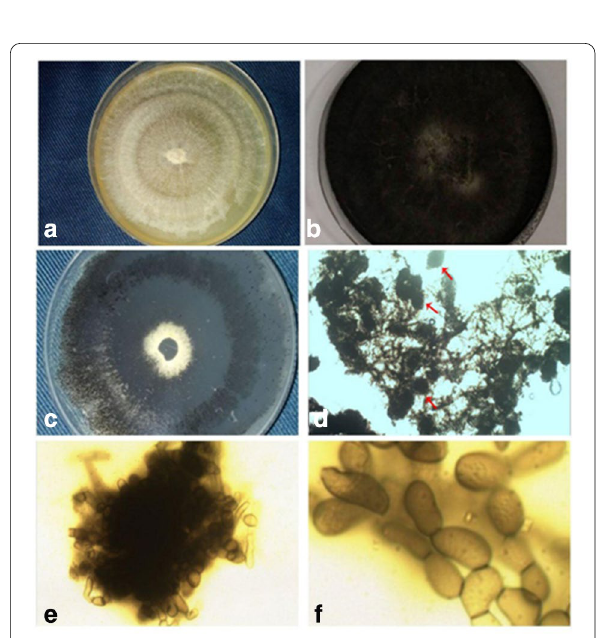
Fig. 9 a M. phaseolina on PDA are one week (top), b M. phaseolina on PDA are three week (top), c M. phaseolina on PDA (bottom), d Pycnidia, e sclerotia, f conidia